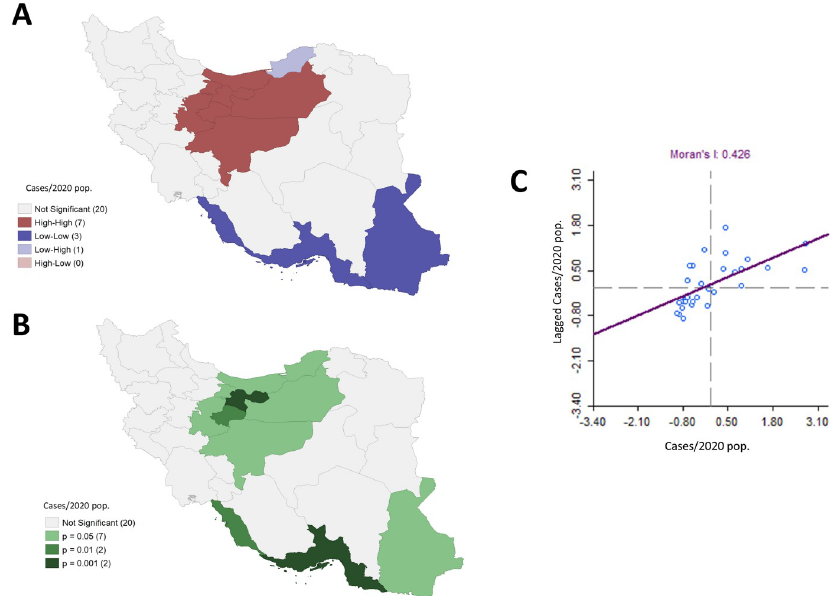
Fig 2. Spatial clustering associated with rates of COVID-19 cases by province from February 19th to March 20th, considering queen contiguity weights. A) Significant spatial clustering obtained through Local Indicators of Spatial Autocorrelation (LISA) comparisons. Four types of a cluster are possible: High-High, Low-Low, High-Low, and Low- High. For instance, the High-High cluster (red) indicates provinces with high values of a variable that are significantly surrounded by regions with similarly high values. B) P-values associated with the spatial clustering in A), C) Scatter plot associated with the smoothed rates vs. their corresponding spatially lagged values, including the associated linear regression fitting, whose slope corresponds to the Moran’s I statistic, a global spatial autocorrelation measure. Shapefiles obtained from the Stanford Libraries Earthworks: https://earthworks.stanford.edu/catalog/stanford-